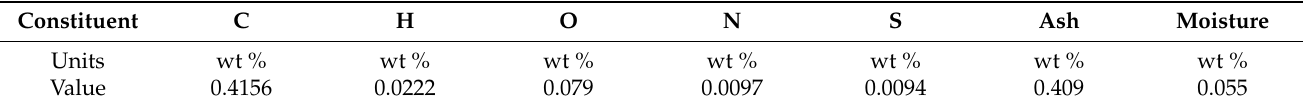
Table 2. Coal composition (from actual fuel analysis).